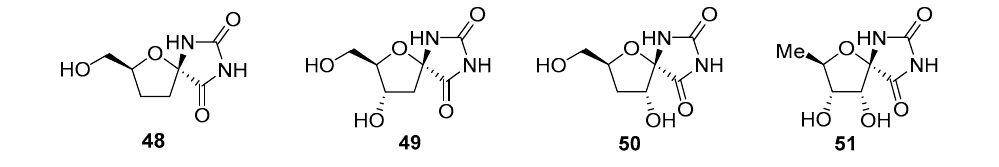
Figure 3. Deoxy analogues of hydantocidin.